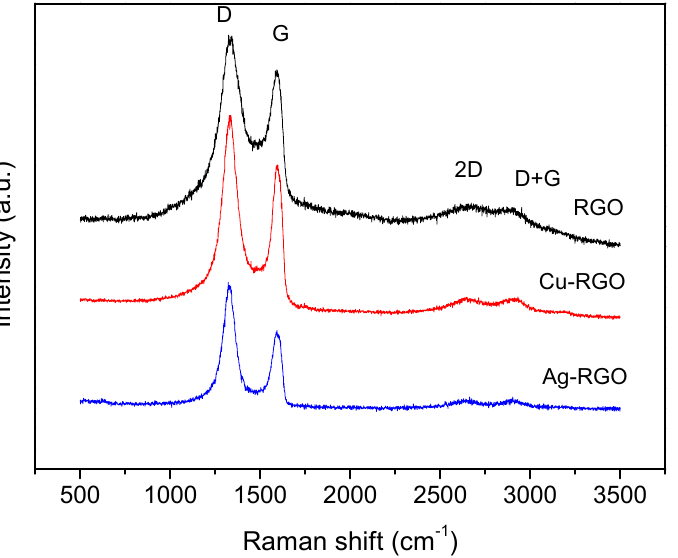
Figure 6. Raman spectra of RGO and the composites Cu–RGO and Ag–RGO. Letters denote major grapheme Raman modes: D—band, G—band, 2D—obertone, D + G—combinational